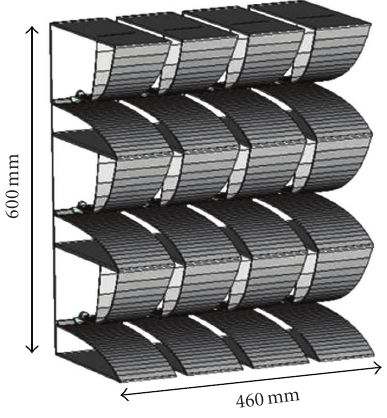
Figure 5: Radiated signals in the frequency